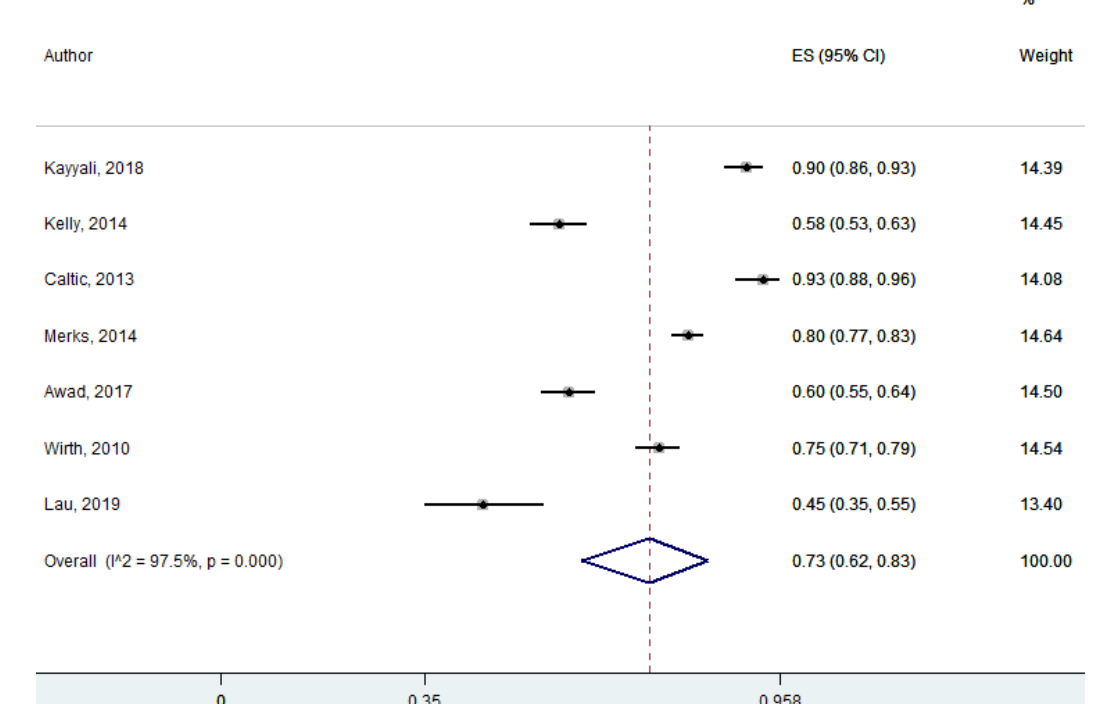
Figure 4. Role of community pharmacists in counselling patients when dispensing medications (seven studies).